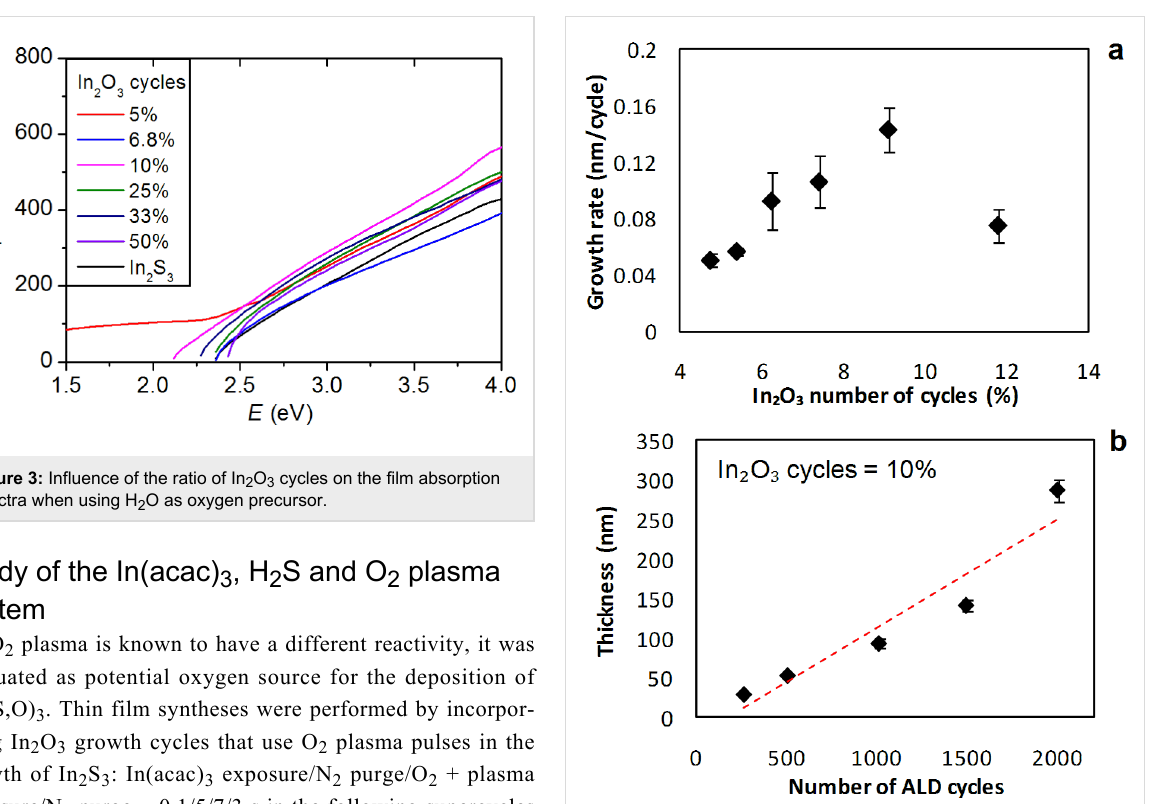
Study of the In(acac) system